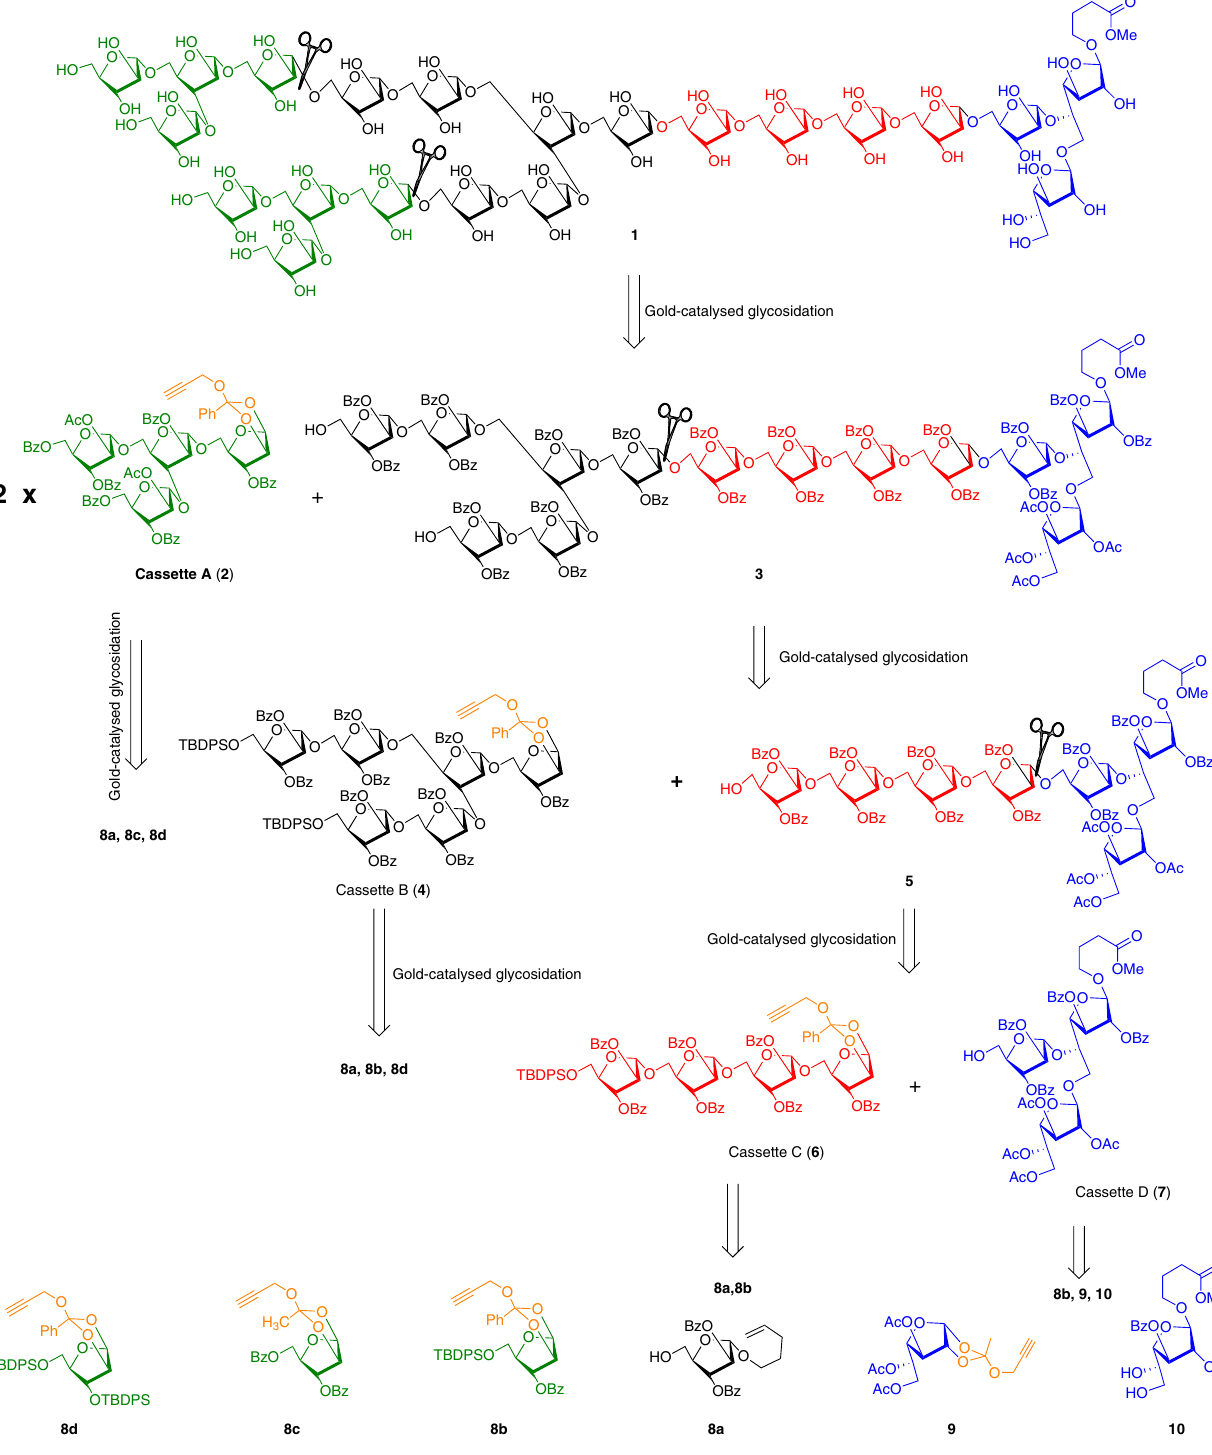
Synthesis of cassette C ( 6 ) commenced with the gold-catalysed glycosidation reaction between donor 8a and aglycon 8b in CH 2 Cl 2 to obtain disaccharide 21 (ref. 38). Deprotection of silyl ether resulted in the aglycon 22 and the treatment of disaccharide 21 with Br 2 in CH 2 Cl 2 followed by propargyl alcohol and 2,6- lutidine, TBAI afforded the glycosyl donor 23 in 85% yield. An